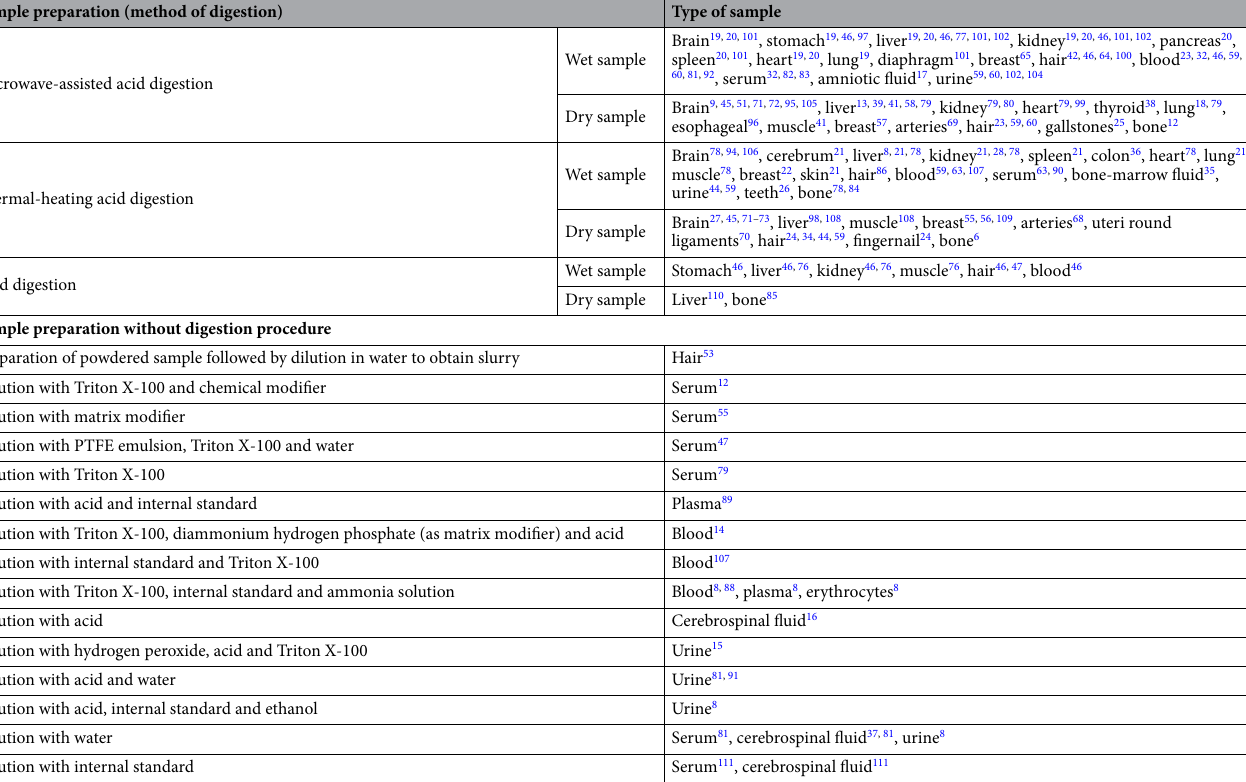
Table 1. Summary of methods used for preparation of biomedical samples for elemental analysis (based on the literature